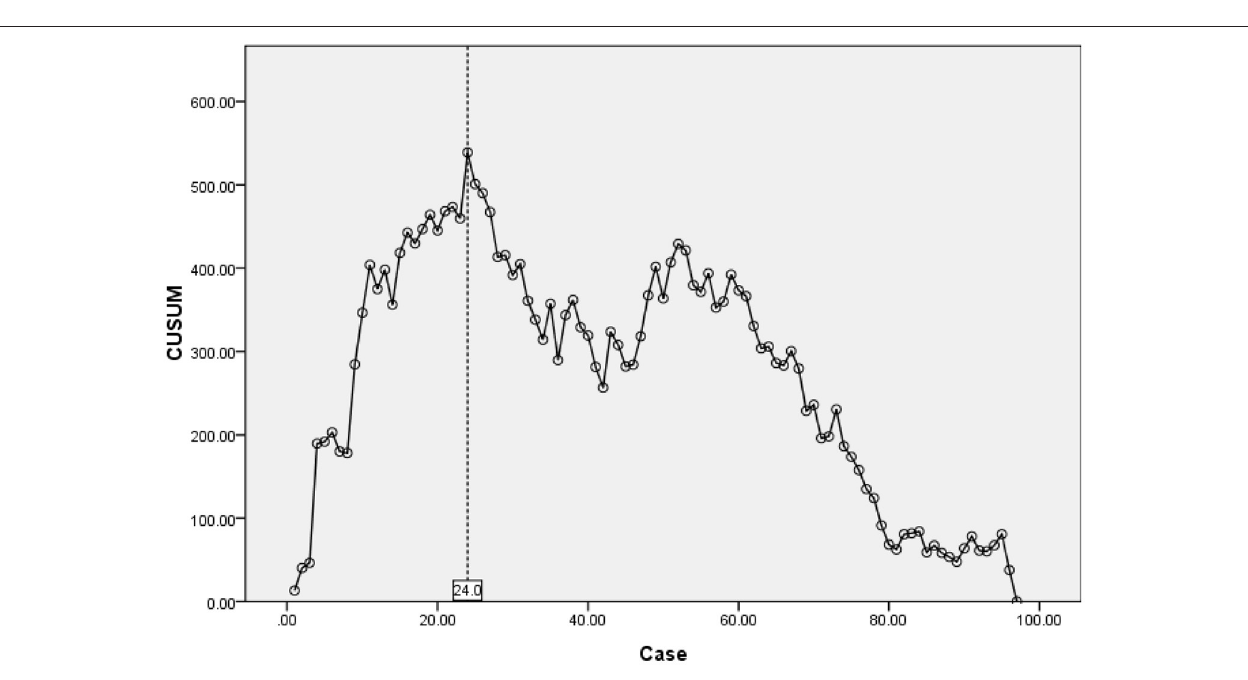
endoscopic technique. UBE can use general arthroscopic